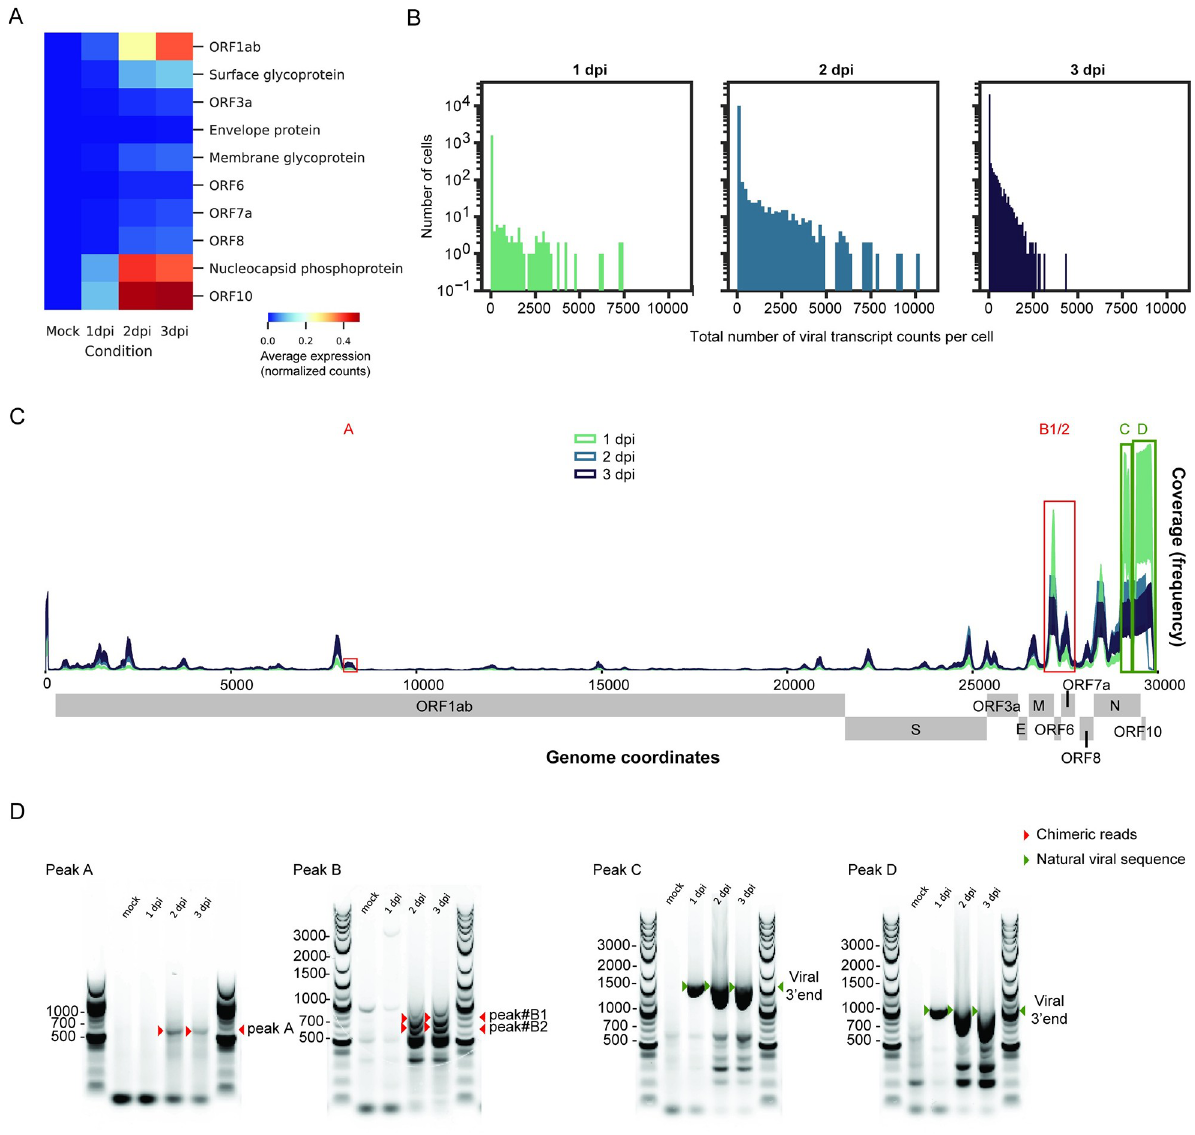
Fig 2. SARS-CoV-2 transcriptome analysis reveals noncanonical transcripts. (A) Heatmap showing average expression (normalized and square- root transformed counts) for reads aligned to individual viral ORFs at each time point. (B) Histograms of viral transcript raw counts per cell on a logarithmic scale for 1, 2, and 3 dpi. (C) Coverage plot of SARS-CoV-2 transcriptome at the scRNA-seq level. The sequencing depth was computed for each genomic position for each time point. The coverage showed both canonical (near the 3 0 end, green boxes) and noncanonical (near the 5 0 end) poly-adenylated sgRNAs. Two unique peaks were identified (red boxes). The individual numerical value per condition for A–C is listed in S1 Data. (D) RT-PCR spanning the junctions between poly-A tails and SARS-CoV-2 genome body for noncanonical transcripts (Peaks A, B1/2, red boxes) and 2 positive controls (Peaks C, D, green boxes). The products were run on agarose gels. Red arrowheads denote the expected amplicons for novel transcripts, while green arrowheads denote amplicons for the natural viral 3 0 end. The raw images for D can be found in S1 Raw Images. dpi, days post-infection; ORF, open reading frame; RT-PCR, reverse transcription PCR; SARS-CoV-2, Severe Acute Respiratory Syndrome Coronavirus 2; scRNA-seq, single-cell RNA sequencing; sgRNA, subgenomic RNA.